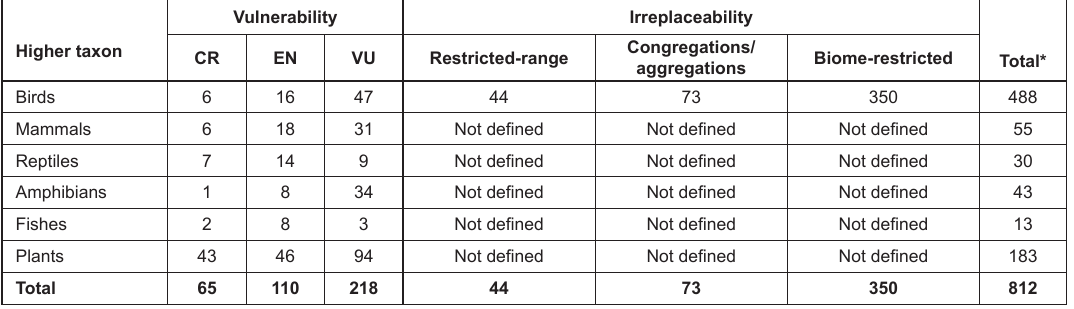
Note: * = species falling into more than one category are counted only once.